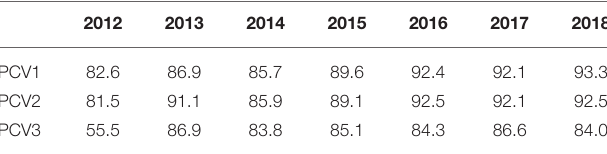
TABLE 3 | Factors associated with IPD case fatality. TABLE 4 | Vaccination coverage (%) with PCV10,